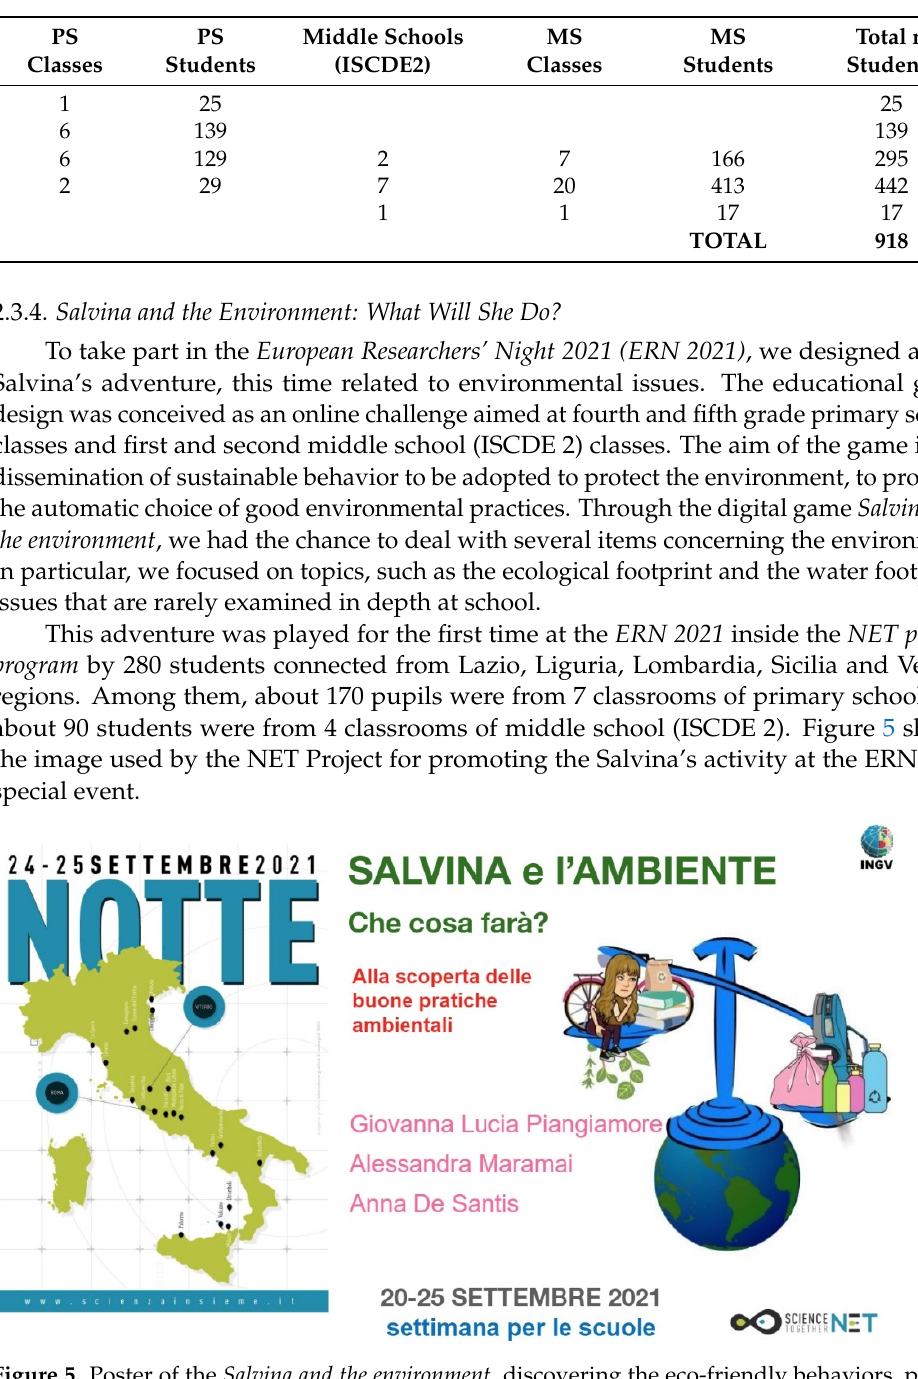
Table 4. Schools involved in the Let’s free Salvina! Escape Room educational online gaming experience.